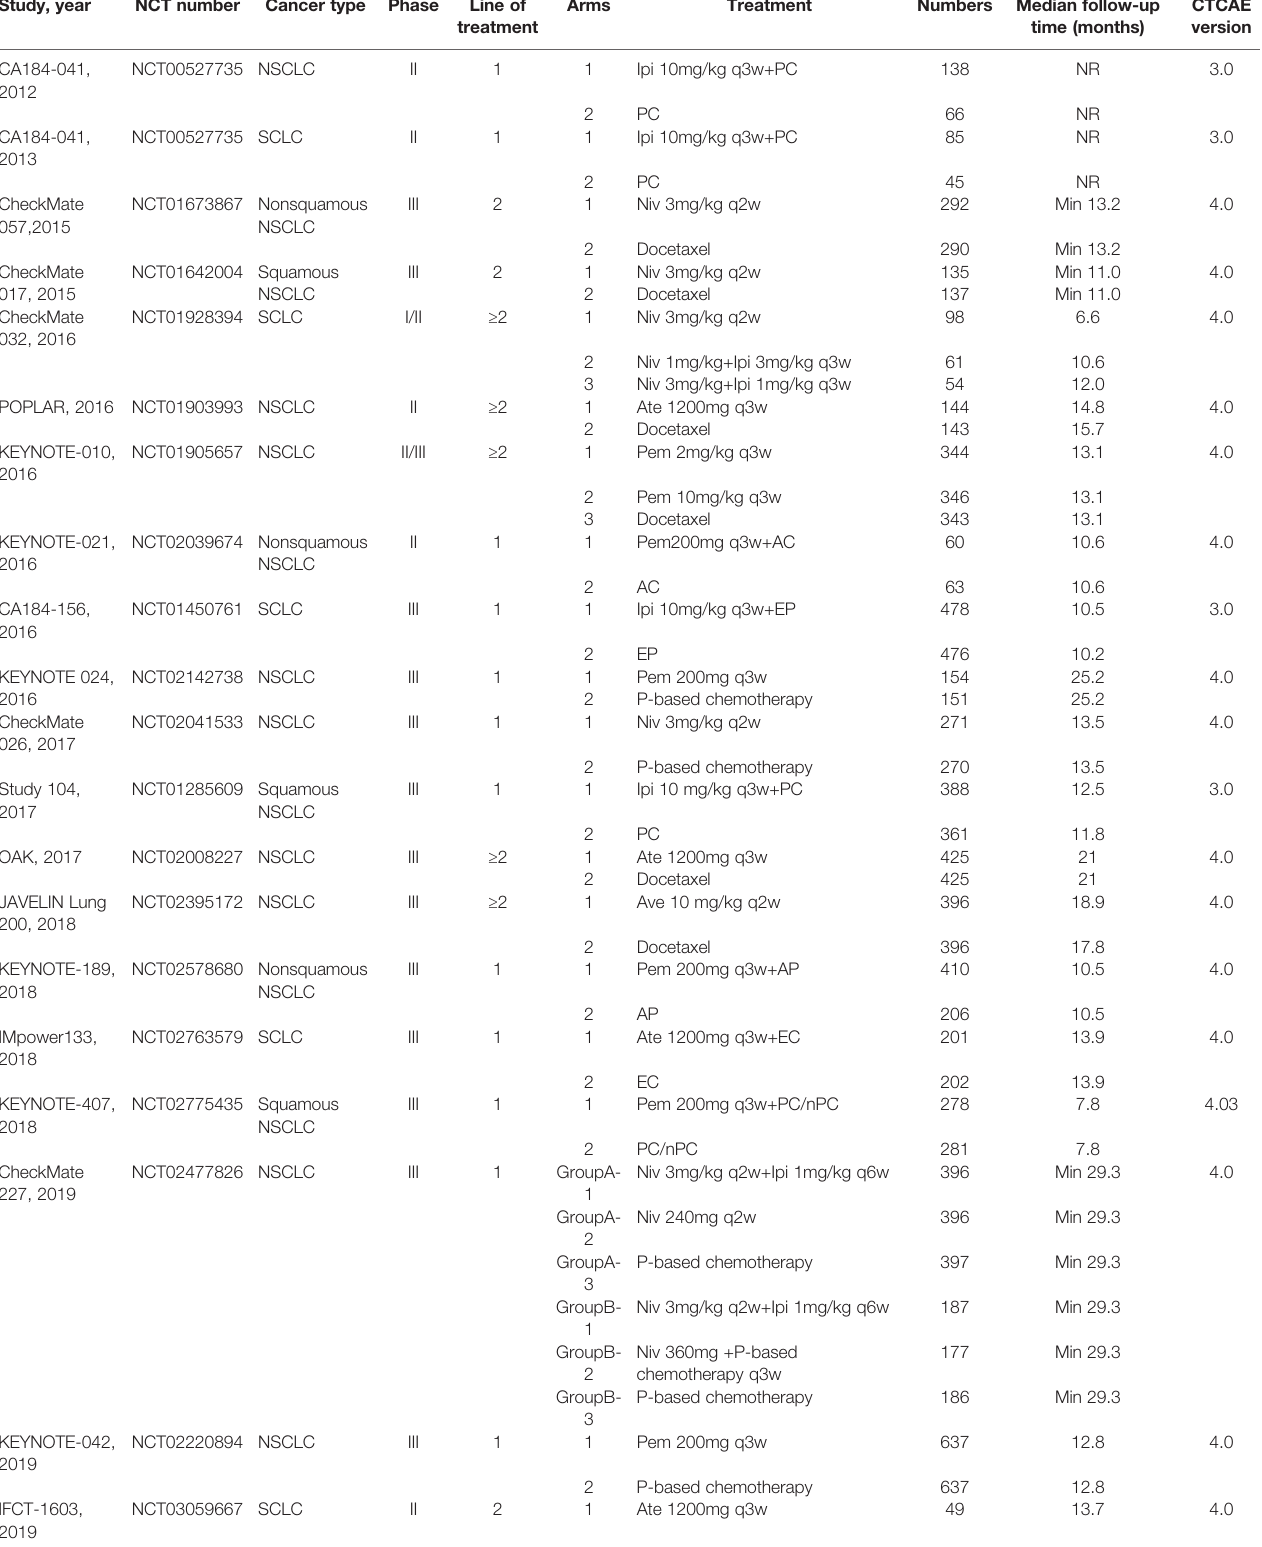
TABLE 1 | Baseline characteristics of 38